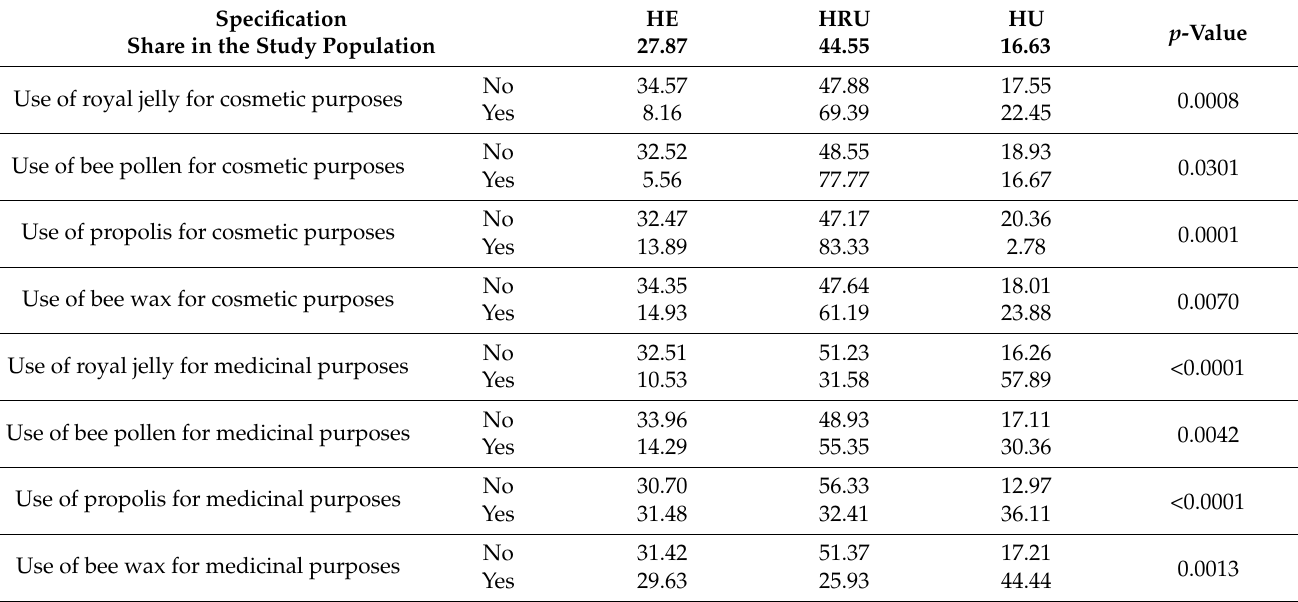
Table 4. Clusters characteristics by usage other than honeybee products (n = 487, data in